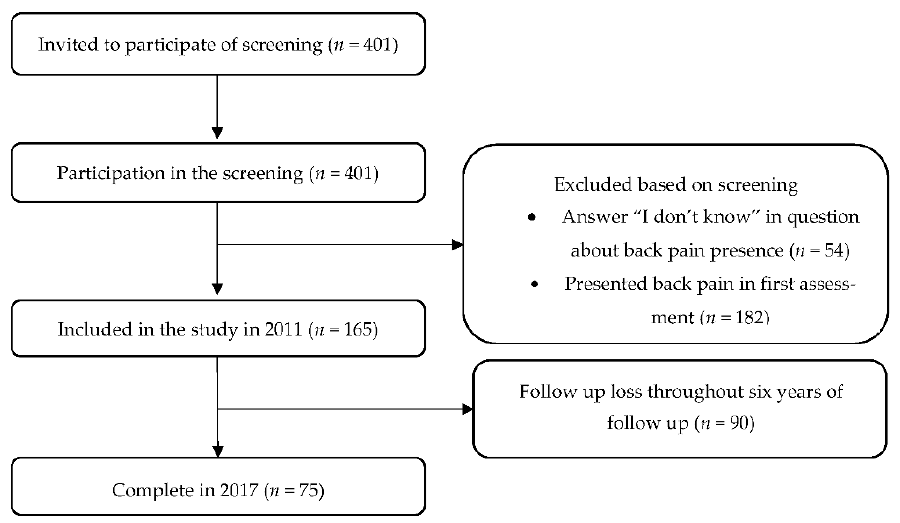
Figure 1. Sample flowchart.